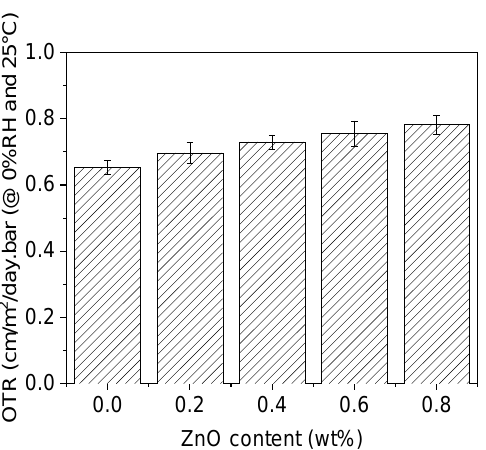
◦ C) of PVA films containing different ZnO weight Figure 7. OTR (@0%RH and 25 °C) of PVA films containing different ZnO weight concentrations. Figure 7. OTR (@0%RH and 25